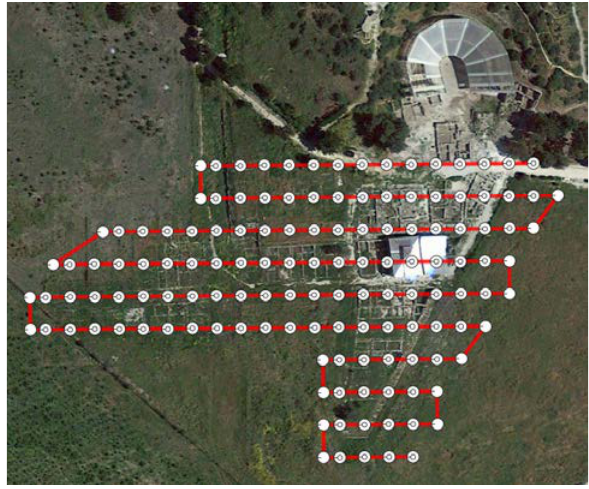
Figure 7. Flight plan of the area of interest.